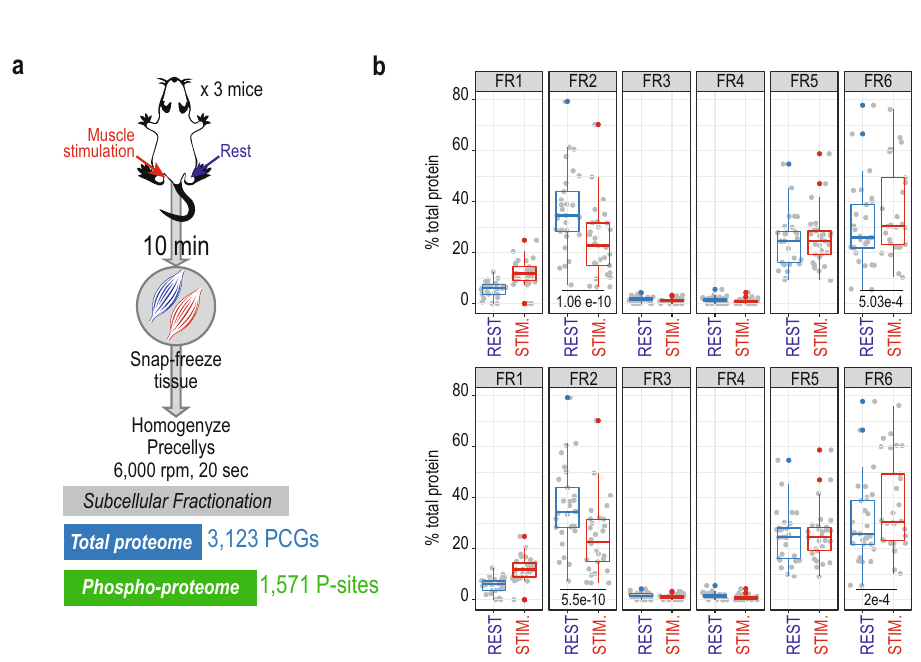
Fig. 7 Muscle contraction in mice recapitulates ribosomal translocation. a Experimental design and work fl ow of subcellular fractionation proteome and phospho-proteome analysis of muscle contraction in mice. b Boxplot of percentage of total ribosomal protein (top: N = 29 40S subunits, bottom: N = 37 60S subunits) across fractions in resting conditions (blue, N = 3 biological replicates) and after muscle contraction (red, N = 3 biological replicates). Statistical signi fi cance is calculated from a two-sided paired t-test from each subset of proteins (40S or 60S), which values were derived from 3 biological replicates in resting against stimulated mice. P-values are indicated in the fi gure. Boxplots show medians and limits indicate the 25th and 75th percentiles, whiskers extend 1.5 times the interquartile range from the 25th and 75th percentiles, outliers are represented by dots. Source Data is provided as a Source Data fi